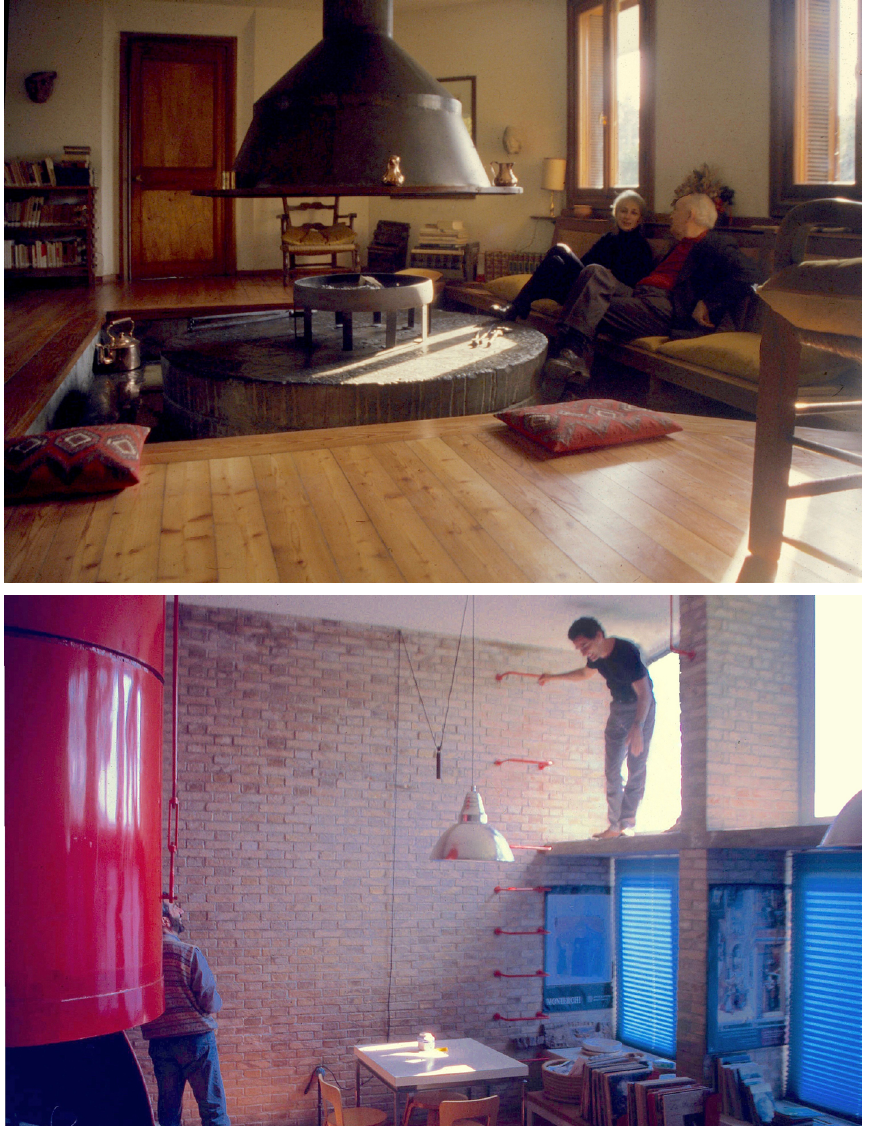
Up: Giuseppe Zigaina, con- versing by his fogolar. Down: Andrea De Carlo, gymnast at Ca’ Romanino.Both